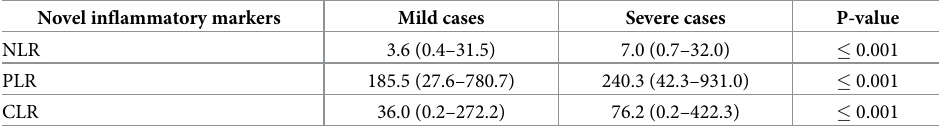
Table 3. The novel inflammatory marker of mild and severe cases with COVID-19.